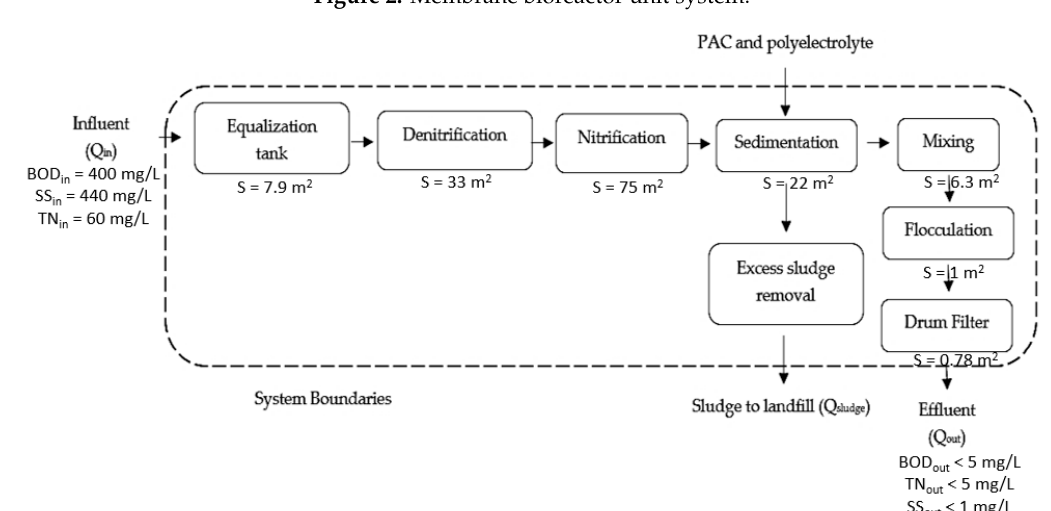
Figure 3. Conventional activated sludge unit system.